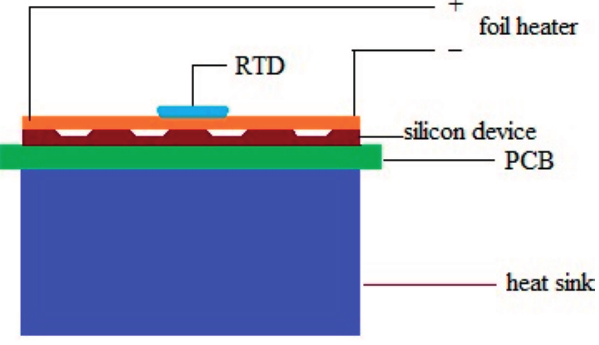
Figure 2. Joule heating experiment